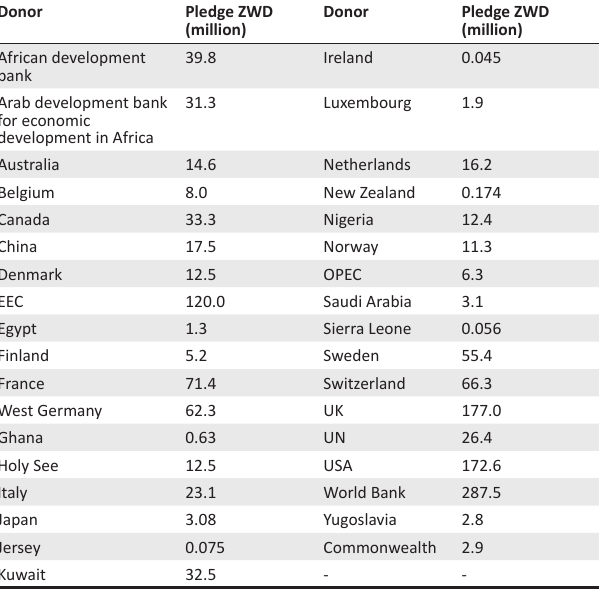
TABLE 1: Zimbabwe conference on reconstruction and development pledges 1981–1984 in Zimbabwean dollars. Donor